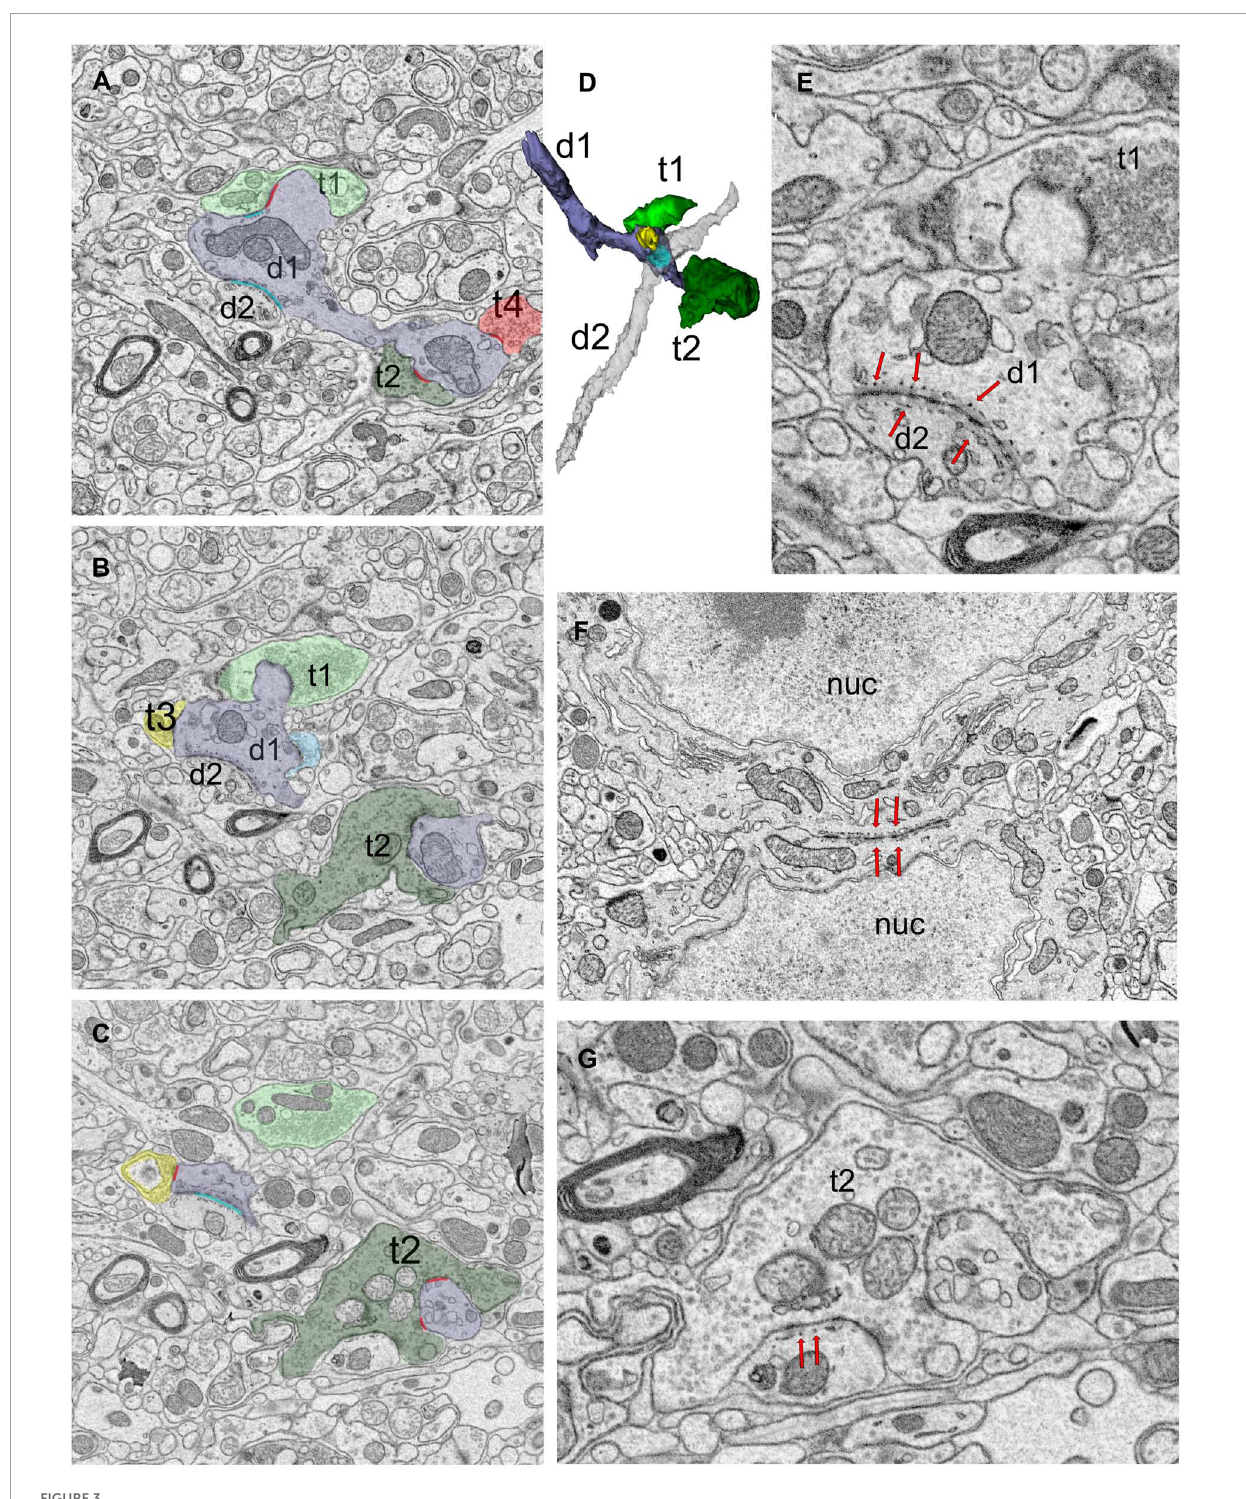
FIGURE3 Dendro-dendritic puncta adherentia (PA) is a characteristic of a relay cell type. (A–C) Cross-section images of a reconstructed dendrite (d1, shaded lavender) that receives synapses from several boutons (t1-t4, pseudo-colored based on UTS volume-sorting classification). Synapses are marked in red (A,C) . The dendrite is also connected to a second dendrite (d2) via PA [marked in cyan in panels (A,C) ]. (D) The reconstruction of the dendrites (d1 and d2, shaded lavender and gray, respectively) forming PA revealed they were both relay cell dendrites, and neither displayed any filopodia, spines or grape-like appendages. (E) Higher magnification view of the dendrodendritic PA (red arrows) reveals close membrane appositions between the plasma membranes and fine tubules or filaments at each side of the dendro-dendritic junction. (F) A PA structure between the neuronal somata (red arrows mark the structure from both sides). The dendrites of such somata that form somatosomatic PAs also displayed dendrodendritic PAs. nuc, nucleus. (G) PA or filamentous junctions (red arrows pointing to structure from the postsynaptic aspect) are frequently observed along with the synapses of large retinal terminals in the LGN. The retinal bouton cross-section (t2) with filamentous junction is from the same bouton labeled as t2 in panels (A–C) , and it synapses on d1 profile that is depicted in panels (A–D) . To note, d1 also forms a dendrodendritic PA with